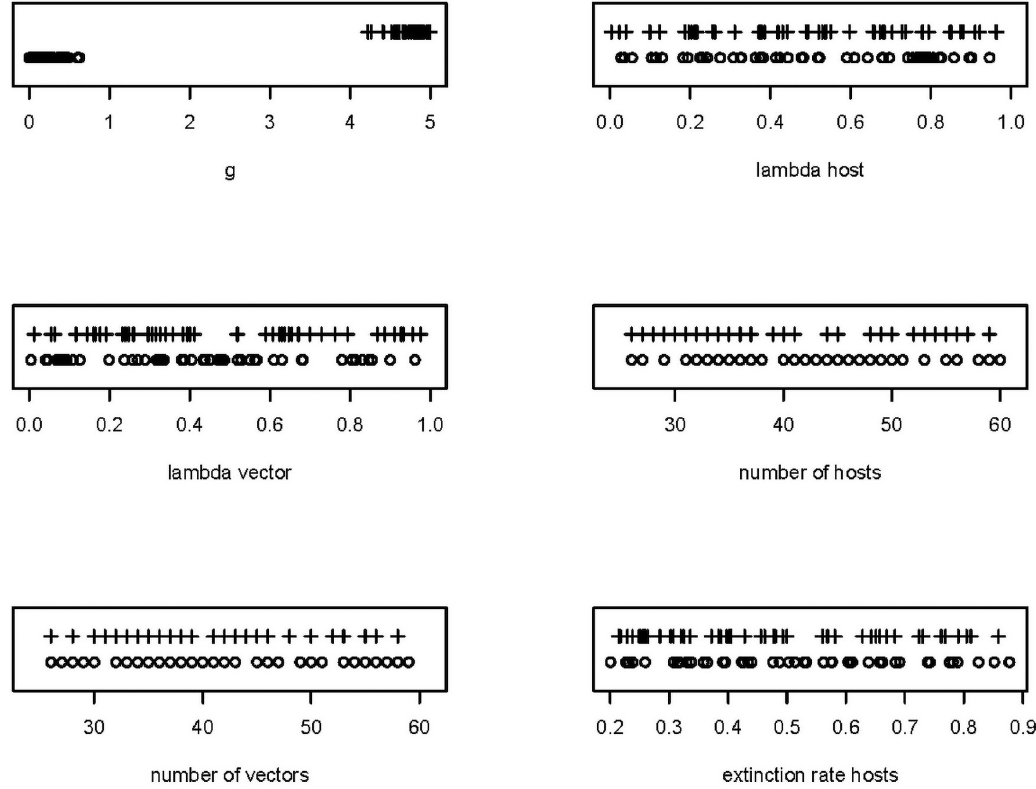
Fig 7. Effects of variables on maximum and minimum values of Q . For each variable, we indicate the 50 highest (+ symbol) and 50 lowest (circles) values of Q 0 from simulations conducted with the LHS. This provides a way to assess whether high extreme output values are consistently associated with particularly high or low values of each